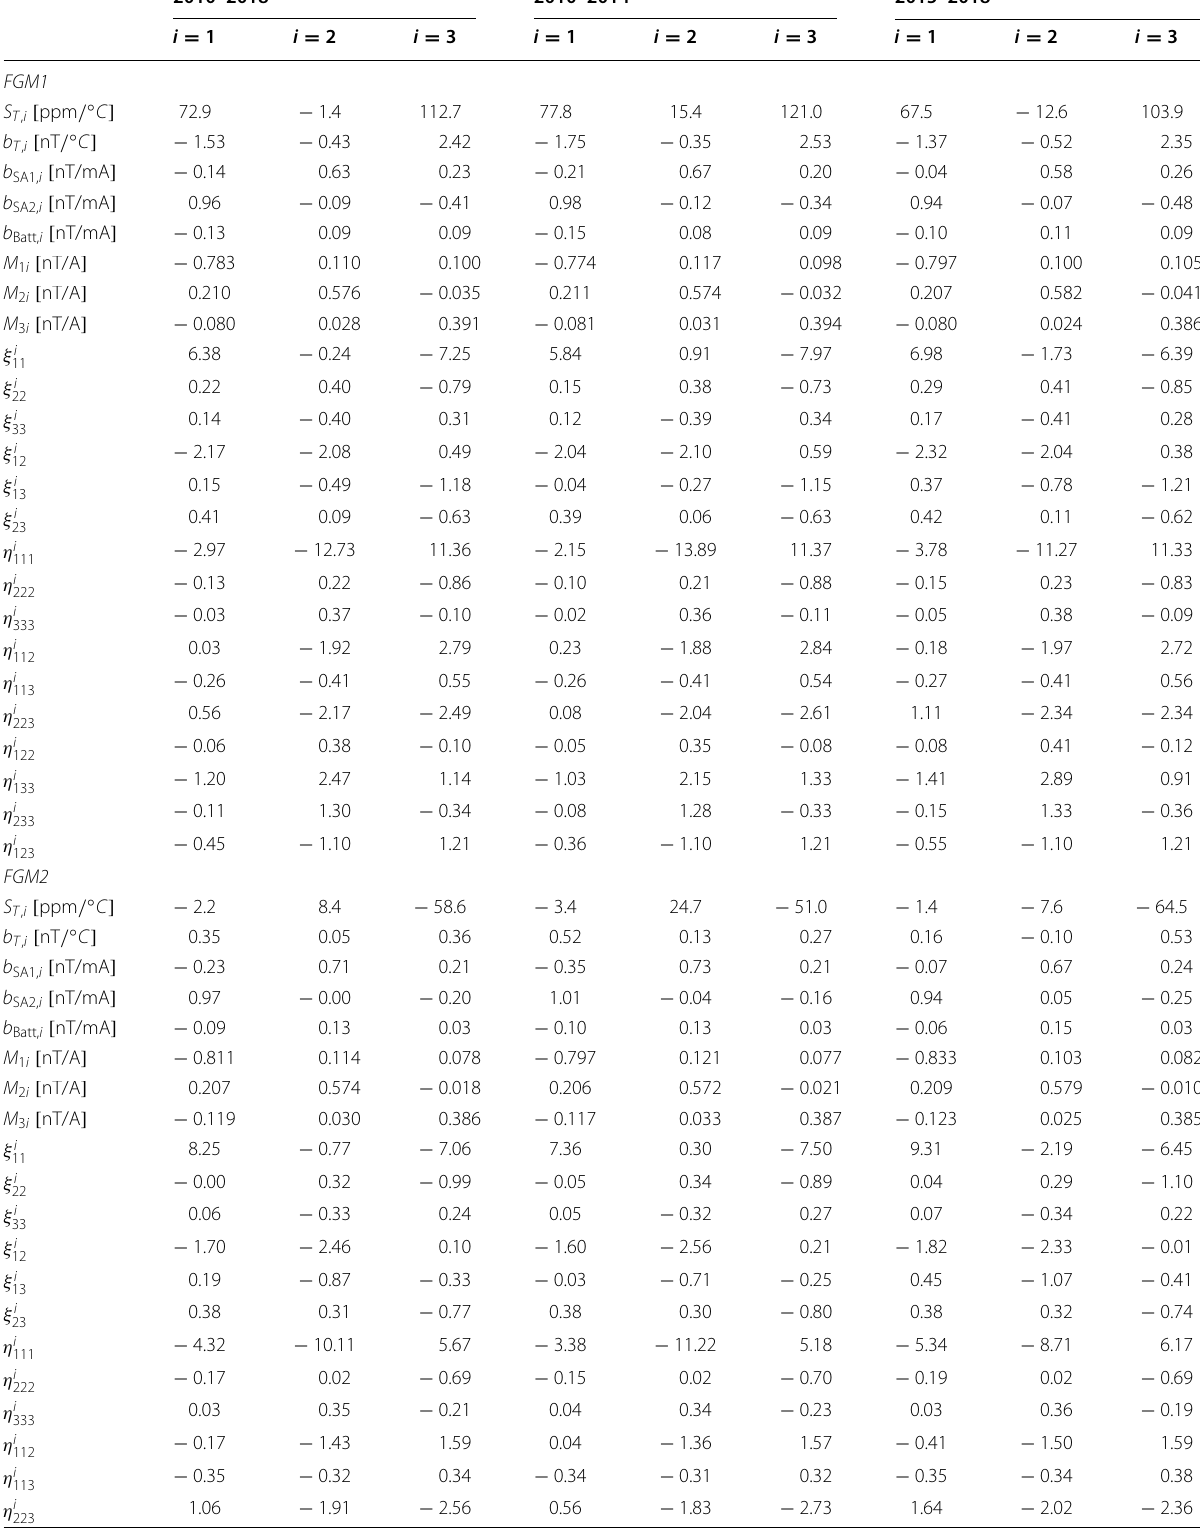
Table 2 Values of the common calibration